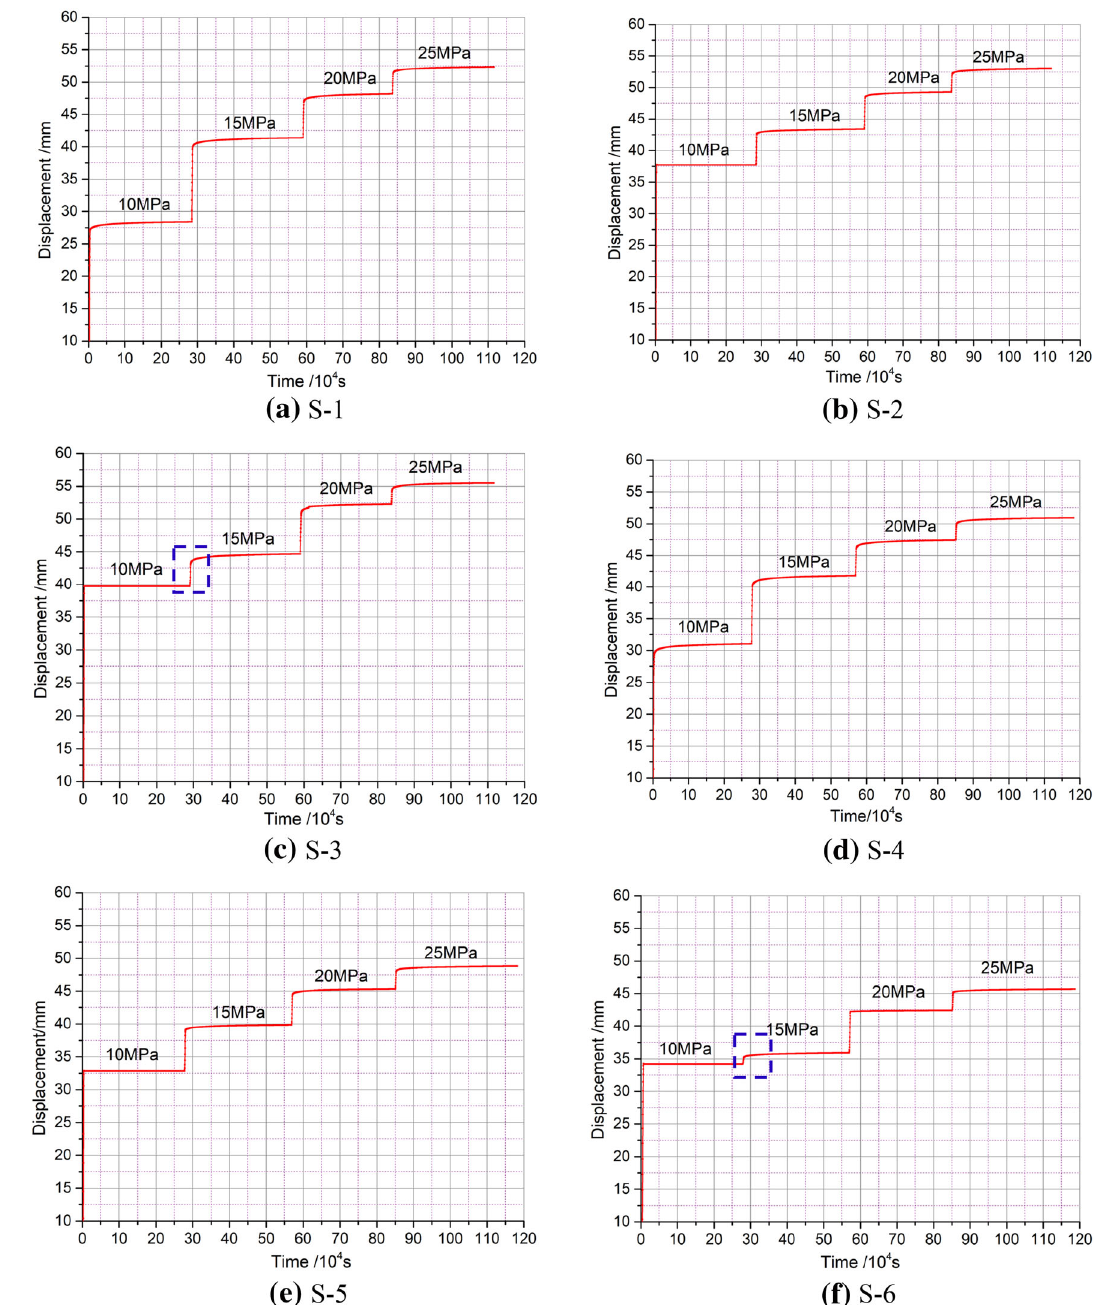
Fig. 5 The time–displacement curves of crushed mudstones with different grain